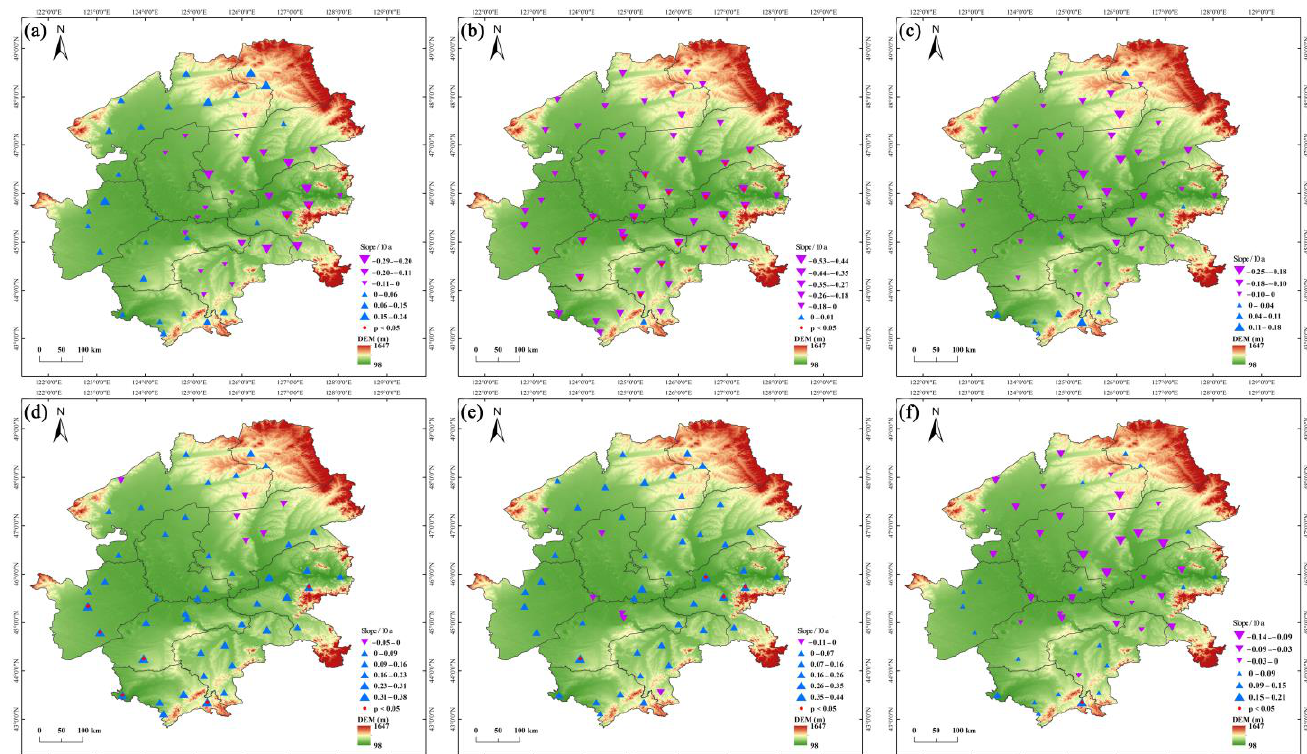
Figure 6. Spatial trend of SCWDI in different growth stages of spring maize: ( a ) the sowing to seedling stage; ( b ) the seedling to jointing stage; ( c ) the jointing to heading stage; ( d ) the heading to milk mature stage; ( e ) the milk mature to mature stage; and ( f ) the whole growth stage.